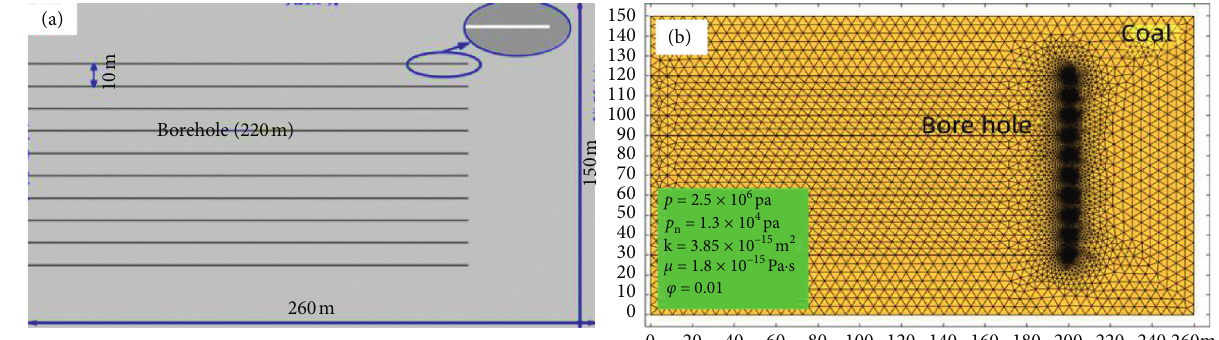
Figure 4: Distribution of air leakage areas around the roadway. (a) Geometric shape and size. (b) Mesh subdivision.